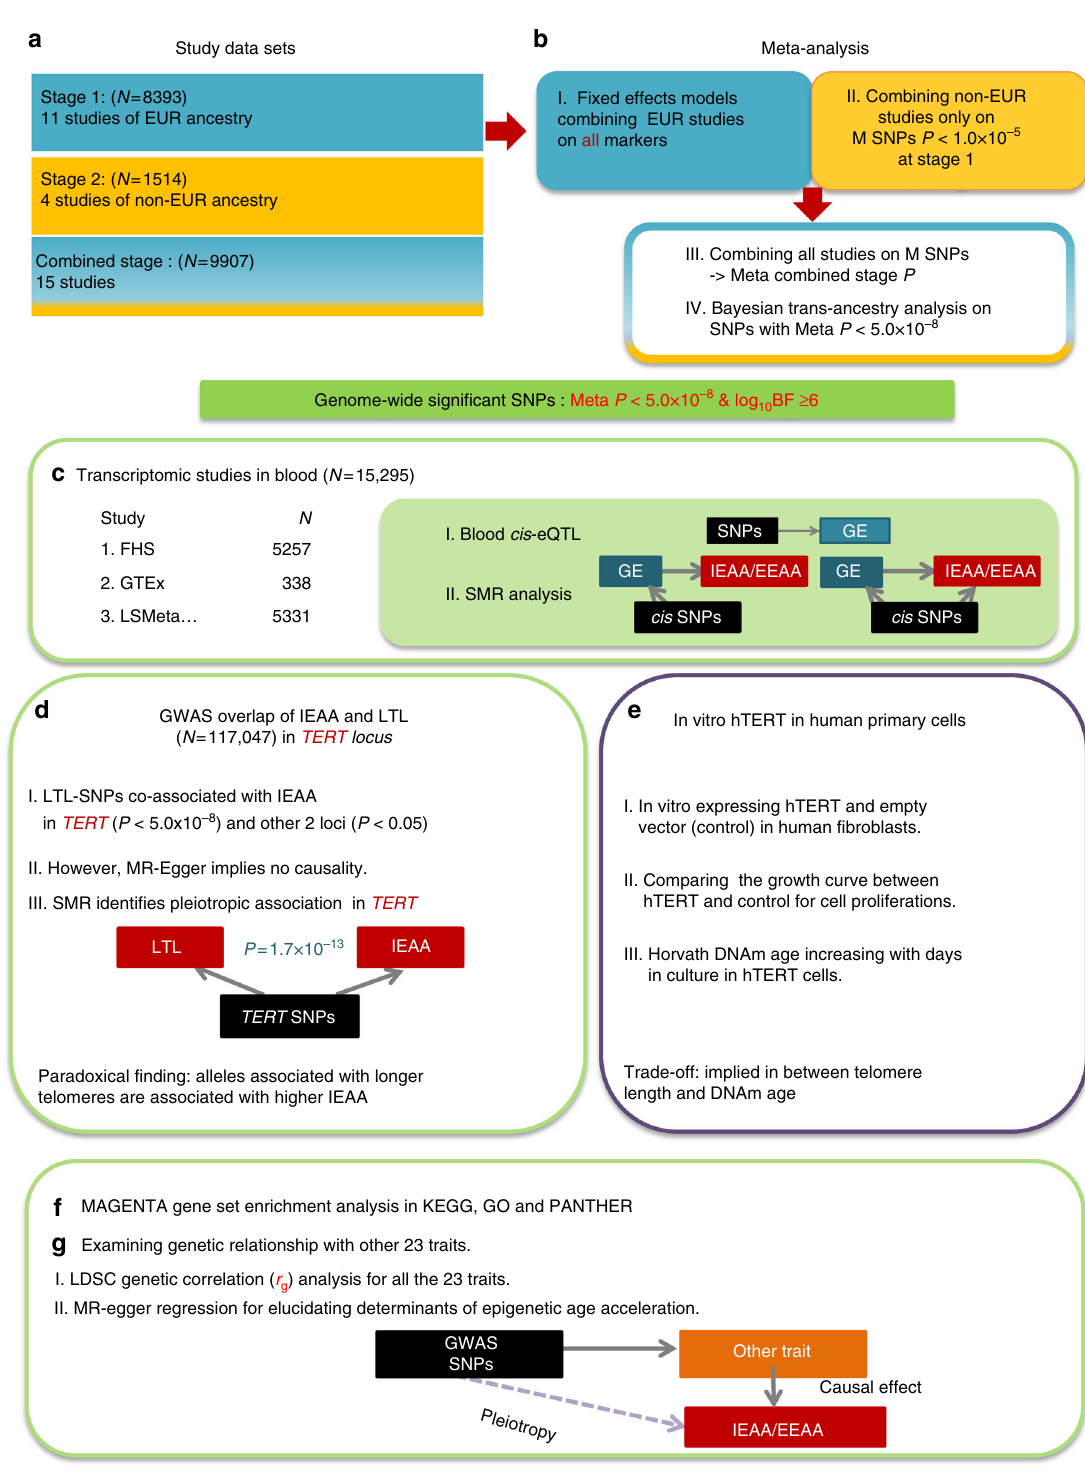
Fig. 1 Roadmap for studying genetic variants associated with epigenetic age acceleration in blood. The roadmap depicts our analytical procedures. a The study sets were divided into two stages according to European (EUR) and non-European ancestry. b Stage 1 yielded GWAS summary data on all QC SNPs and the combined stage yielded GWAS summary data on the SNPs with Meta EUR P < 1.0 × 10 − 5 at stage 1. Genome-wide signi fi cant loci were determined based on the association results from the combined stage. c Describes our transcriptomic studies: (I) blood cis -eQTL to identify potential functional genes, (II) summary statistics based Mendelian randomization (SMR) to assess the causal associations between expression levels and IEAA (or EEAA). d Describes our detailed analysis in the TERT locus, which was implicated by our GWAS of IEAA. Bidirectional Mendelian randomization via MR-Egger analysis did not reveal a direct causal effect between leukocyte telomere length and IEAA. Our in vitro studies validate our genetic fi ndings by demonstrating that hTERT over-expression promotes epigenetic aging in e . To explore molecular pathways underlying epigenetic age acceleration, we conducted gene set enrichment analysis, as listed in f . Finally, we performed LDSC genetic correlation between IEAA or EEAA and a broad category of complex traits, followed by MR-Egger regression analysis, as depicted in g . Abbreviations: GE = gene expression, LTL = leukocyte telomere